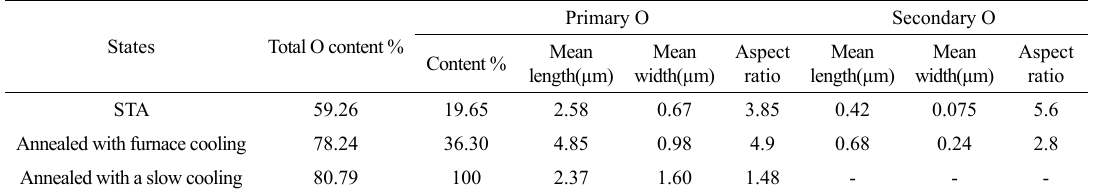
Figure 3. As-adjusted microstructures of current wrought Ti Table 1. Microstructure characteristics of O-phase